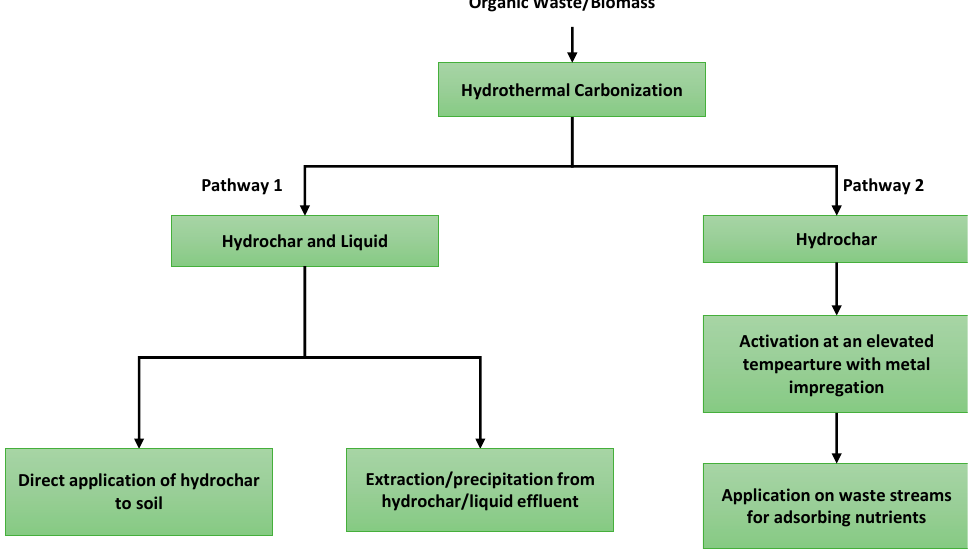
Figure 7. Pathways of nutrient recovery from hydrochar.